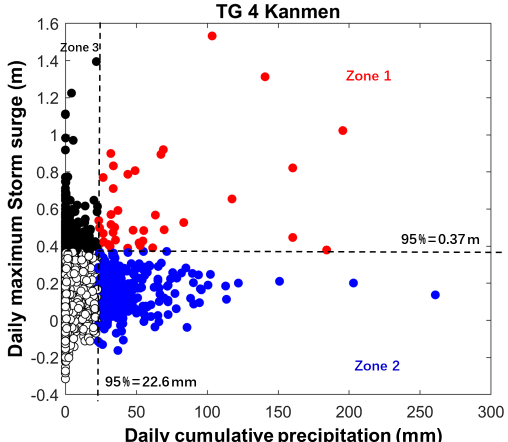
Figure 2. Daily maximum storm surge plotted against daily cumula- tive precipitation for threshold of 95%. Red dots (plotted in Zone 1) show joint occurrence of high storm surge and heavy precipitation, whereas blue (Zone 2) and black (Zone 3) dots define events where only one flooding driver is